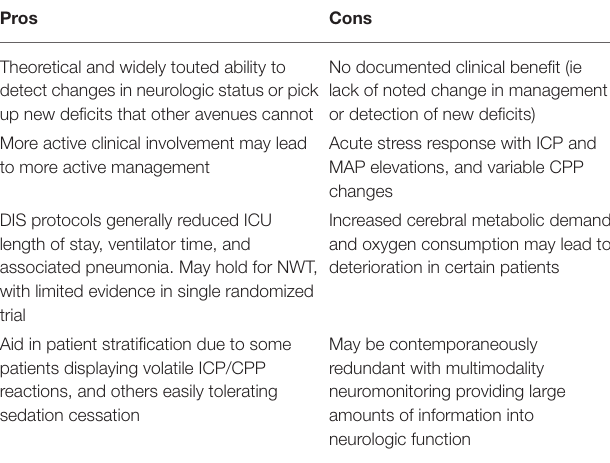
TABLE 2 | Brief outline of a list of pros and cons of the